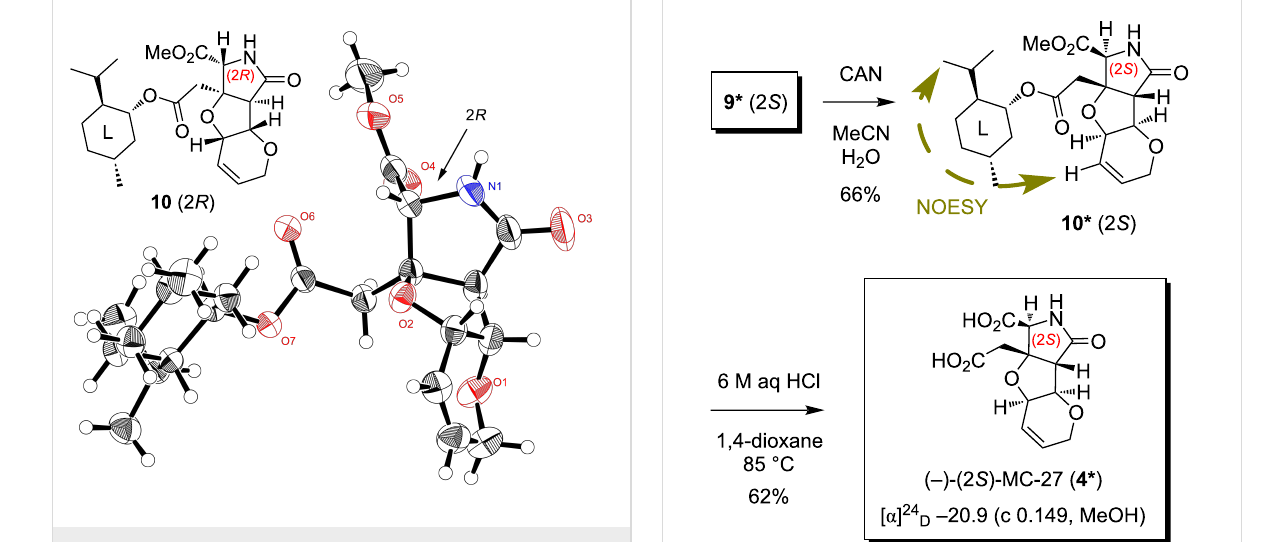
Figure 4: Crystallographic analysis of the menthyl ester 10 , unequivo- cally showing the 2 R configuration (CCDC 2030829).